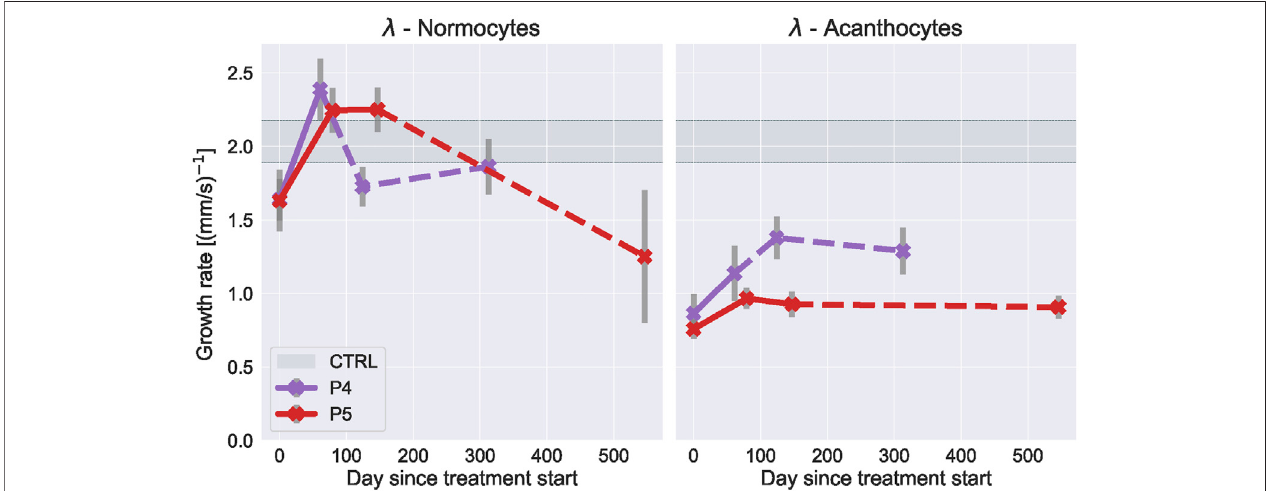
FIGURE3| LithiumtreatmenteffectonRBCdeformability.(onecolumn fi gure)Fittedgrowthrate λ oftheshapeprobabilitycurvesfromChAcpatientsasafunction of treatment time with lithium for normocytesand acanthocytes respectively.Dashed linesrepresent datapoints taken after treatment was stopped. Errorbars represent standard error of the fi t, calculated from the covariance matrix. Gray region shows the respective value from healthy donors without treatment (Mean ± SD).